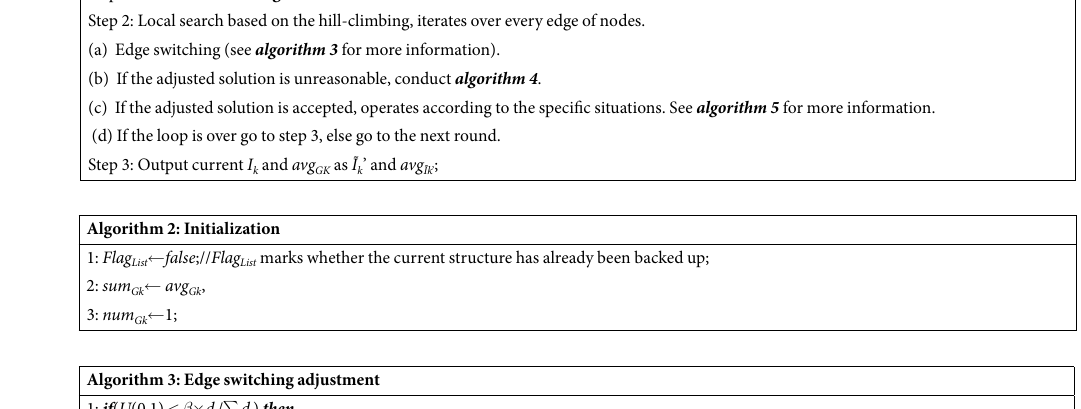
Algorithm 3: Edge switching